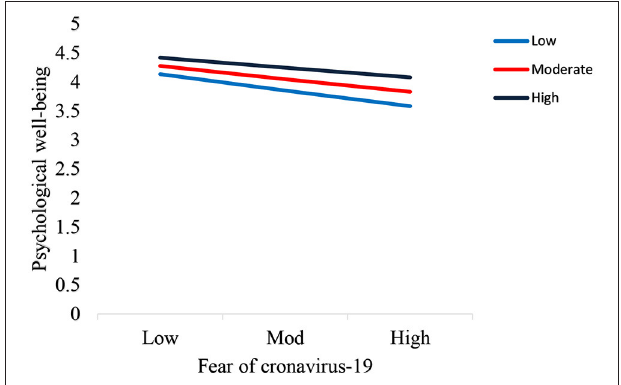
FIGURE 4 | Interaction plot of the Fear of COVID-19 and emotional intelligence on psychological